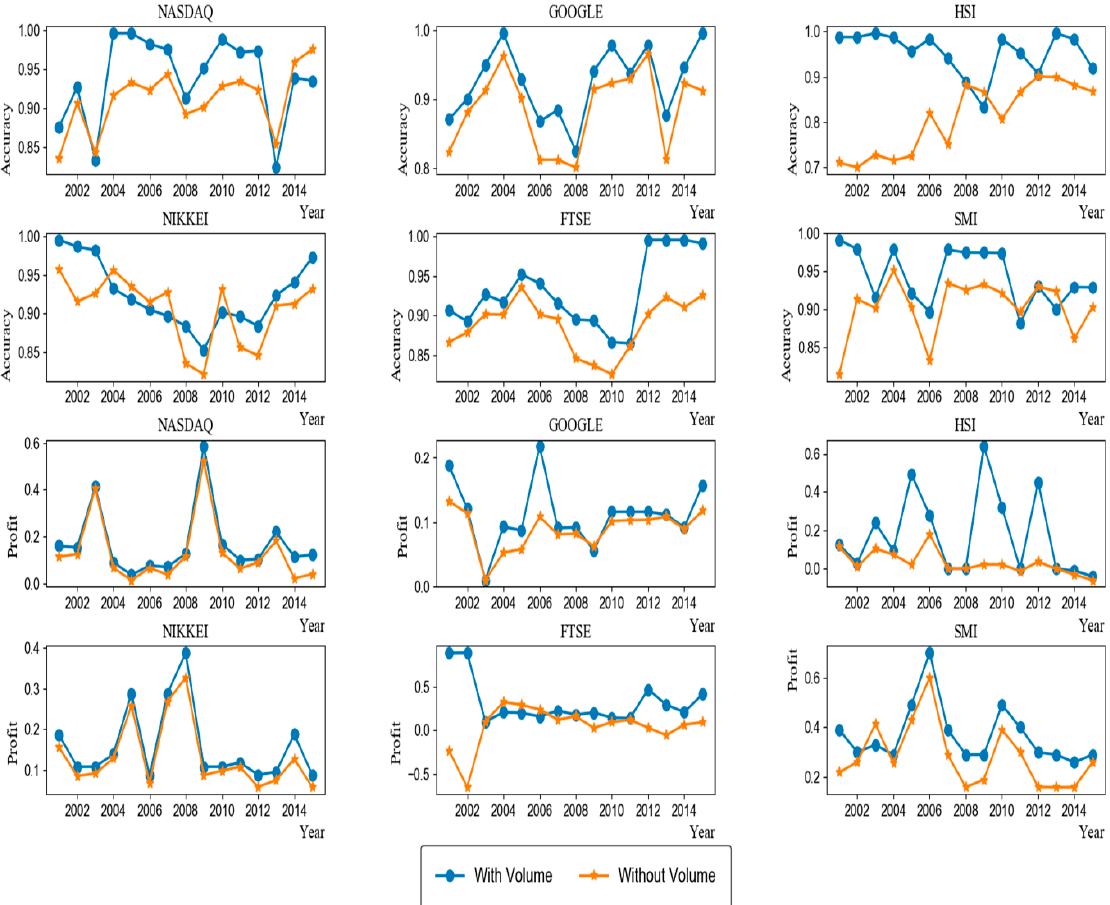
Figure 8. Comparison of the performance between our model and other models without volume input data for the MLPs learning method.